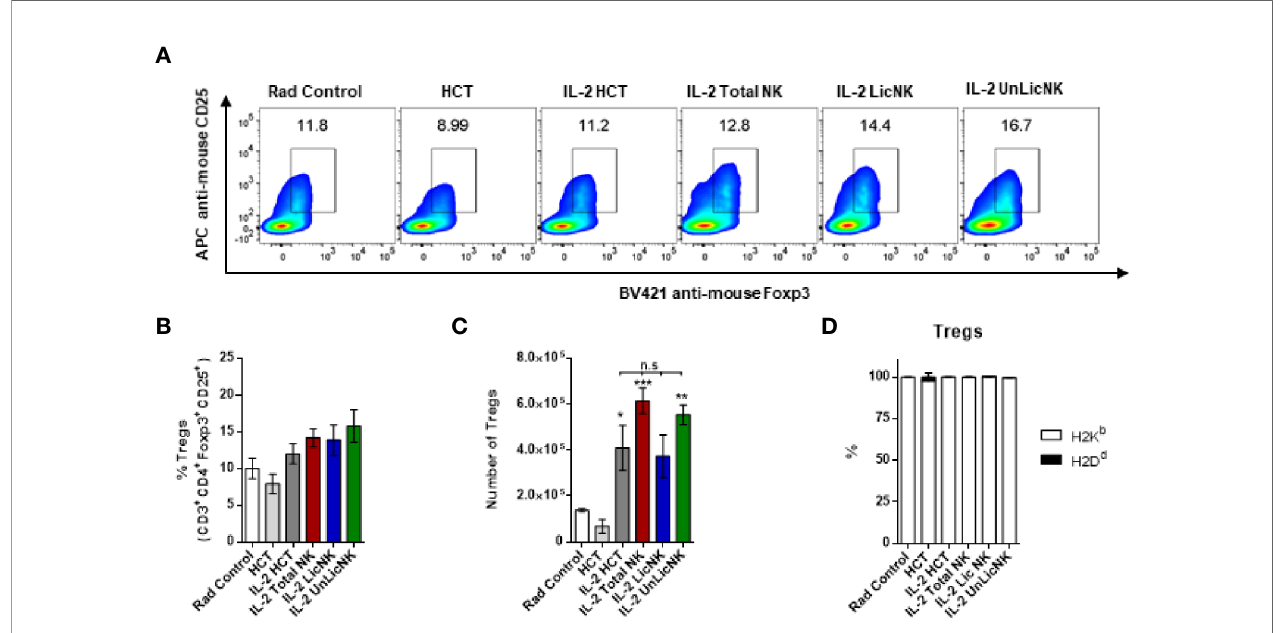
FIGURE 6 | The number of Tregs is slightly increase by UnLicNK cell treatment during NMAC HCT. (A) Representative dot-plots of Foxp3 and CD25 is shown for gated CD4 T cells. (B) Total percentage of Foxp3 + CD25 + CD4 Tregs is shown for gated CD4 T cells. (C) Total number of Tregs is shown. (D) Proportion of host (H2K b ) and donor (H2D d ) is shown for Tregs. Data is representative of two independent experiments with n=3 – 5 per group (mean ± SEM). Two-way Anova (A) or One-way ANOVA were used to assess signi fi cance. (*p<0.05, **p<0.01, ***p<0.001, n.s, no signi fi